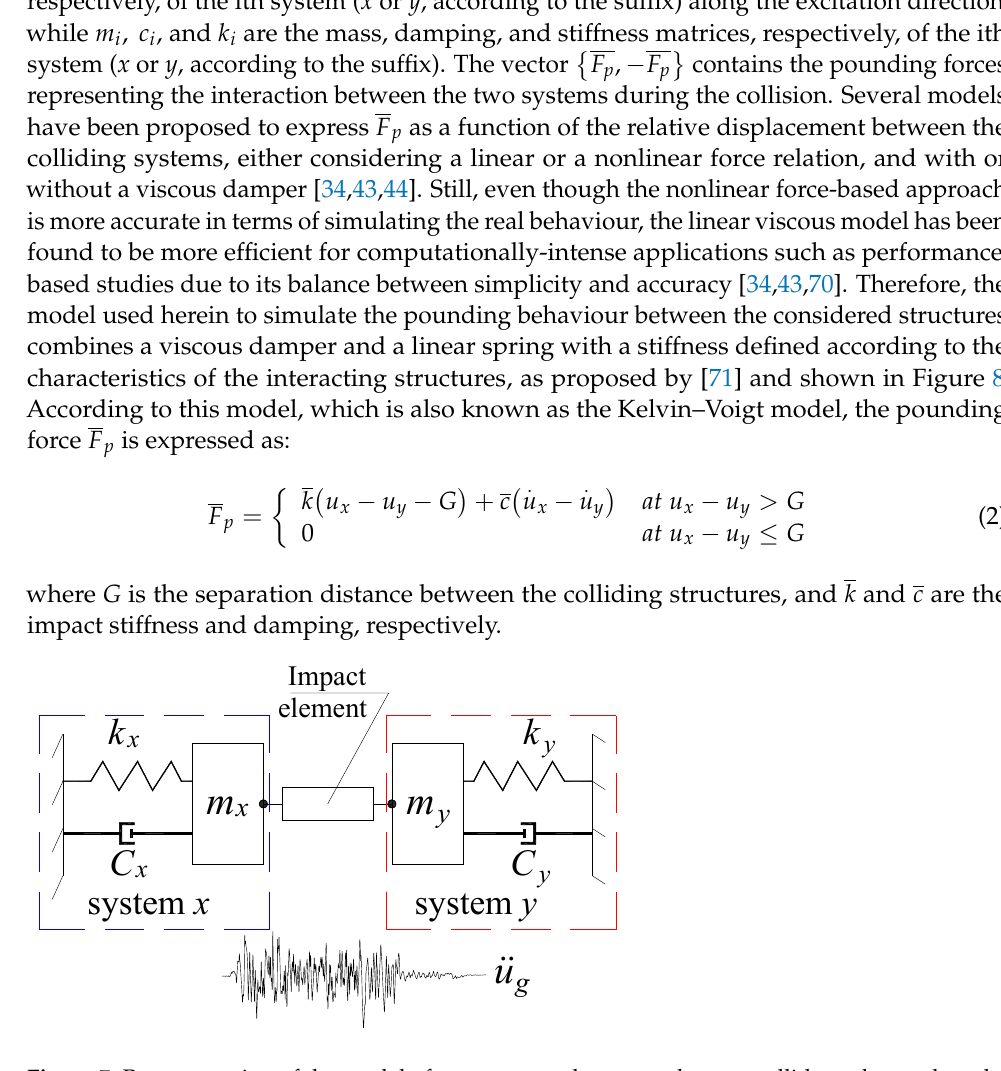
Figure 7. Representation of the model of two structural systems that can collide under earthquake excitation.